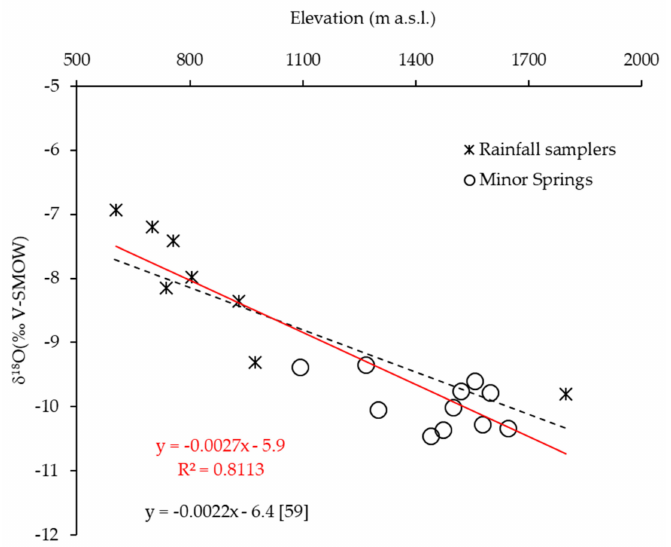
Figure 5. Linear regression between δ 18 O and elevation determined by eight rain gauges’ water collectors and eleven minor springs of the area obtained in this study (red solid line) and linear regression obtained by [59] for the same area (black dashed